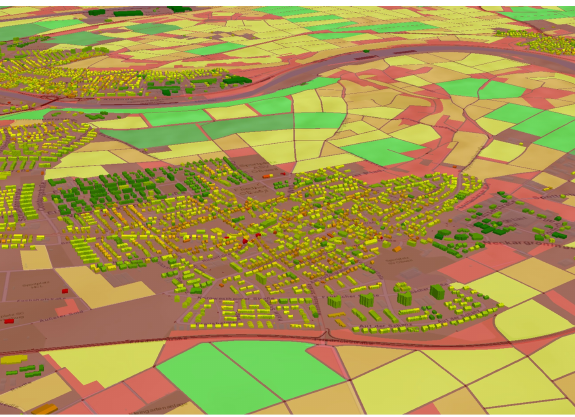
Figure 9, the aggregated building specific space heating demand on each parcel is visualized. It is pre-styled on the server-side and loaded to the application as tile imagery through the OGC WMS to boost the application performance.